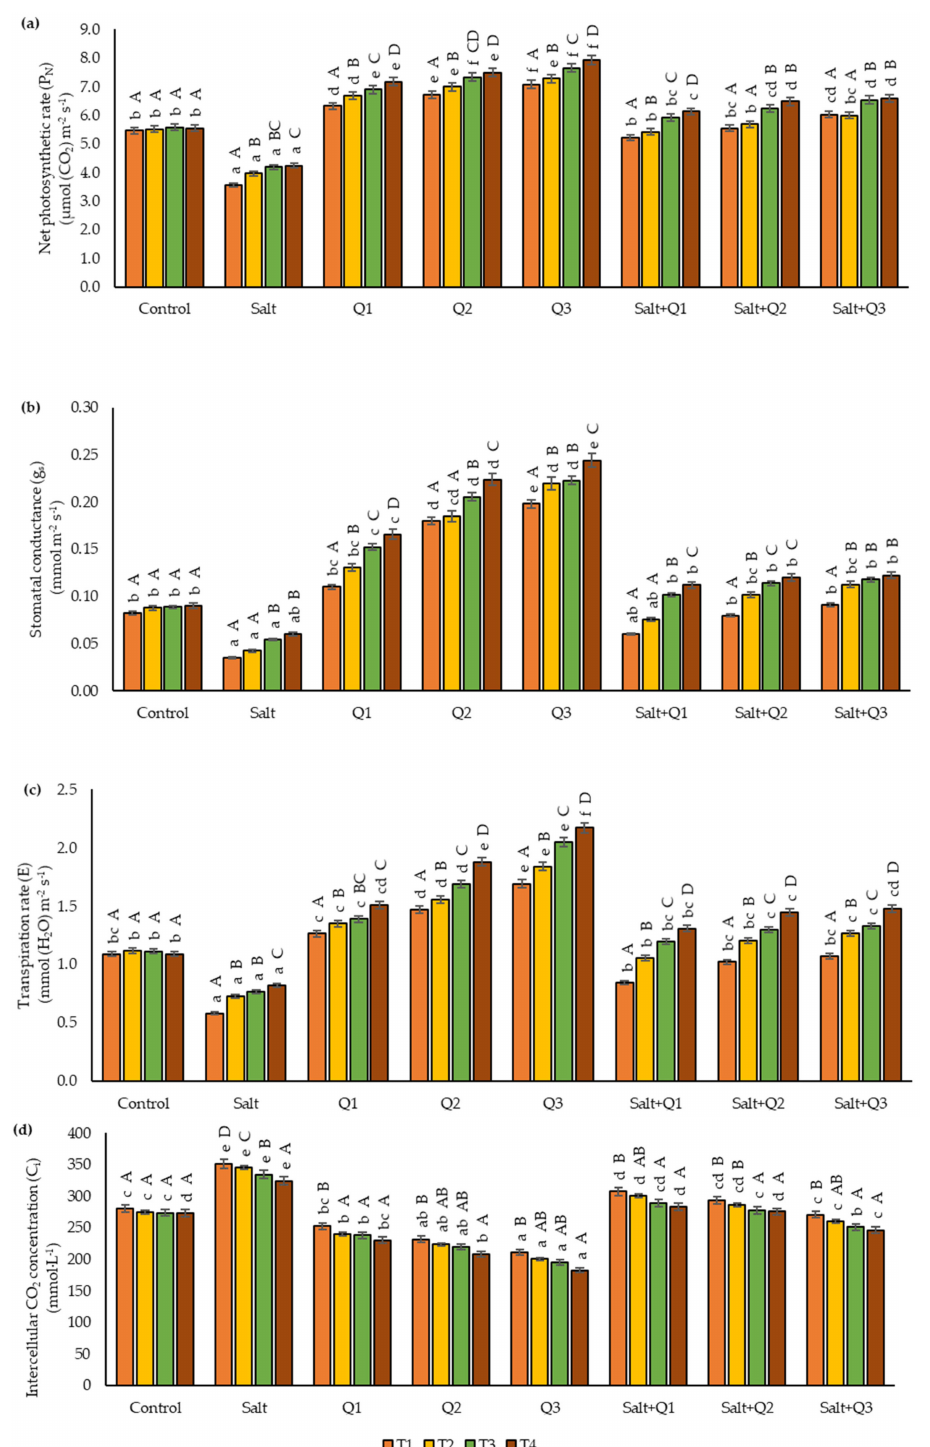
Figure 3. Effect of quercetin–copper complex (Q-Cu (II)) concentrations, salt stress, and terms of measurement on gas exchange parameters: ( a ) net photosynthetic rate (P N ); ( b ) stomatal conductance (g s ); ( c ) transpiration rate (E) and ( d ) intercellular CO 2 concentration (C i ). (T1—the first day after the first application, T2—the seventh day after the first application, T3—the first day after the second application, T4—the seventh day after the second application). Capital letters indicate significant differences between the means at measurement terms for each variant of the experiment, lowercase letters indicate significant differences between the means at respective measurement terms according to ANOVA followed by Tukey’s HSD test, p =